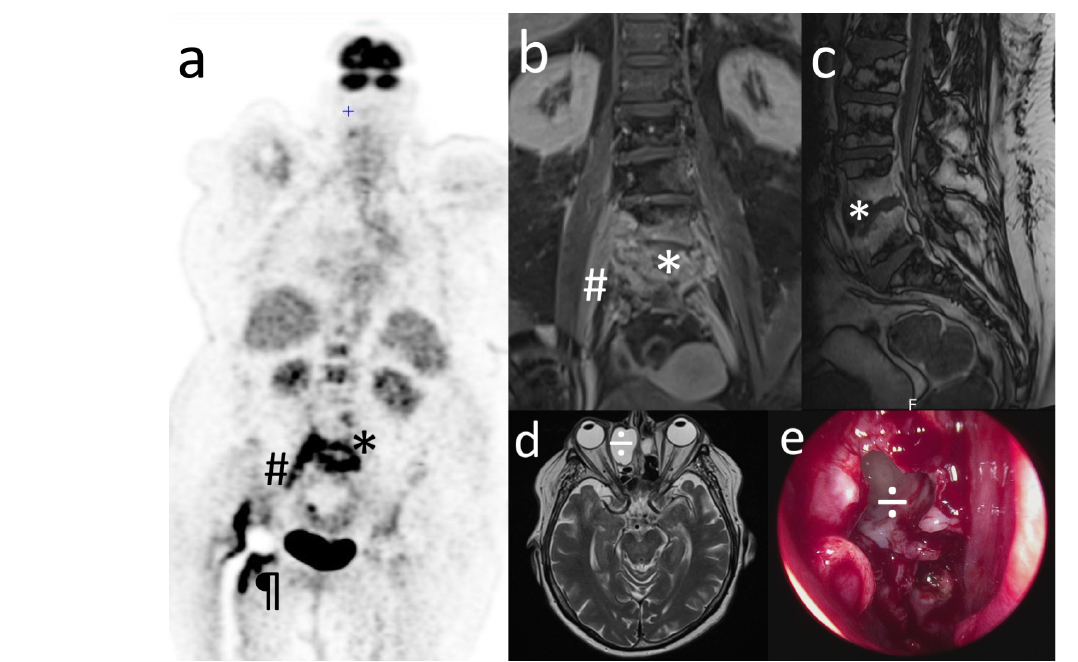
Figure 1. Non-typeable Haemophilus influenzae invasive spondylodiscitis started from a bacteremia of the ENT entry site and shows an unreported mechanism of dissemination. (a) PET scan; other images show a continuous fixation along the iliopsoas muscle; (b, c) spine and pelvic T1-weighted gadolinium-enhanced MRI: ∗ L4–L5 spondylodiscitis with epidural abscess; # right medial iliopsoas infiltration; ¶ hip prosthesis infection. (d) Sinus T2-weighted MRI and (e) peri-operative view of endo-nasal surgery after opening the right ethmo-orbital mucocele: ÷ mucocele revealed a clear mucoid content that underwent Haemophilus influenzae -specific PCR, positive for a non-typeable strain. (a) , (b) , (c) , and (d) are courtesy of the Radiology Department of Gustave Dron